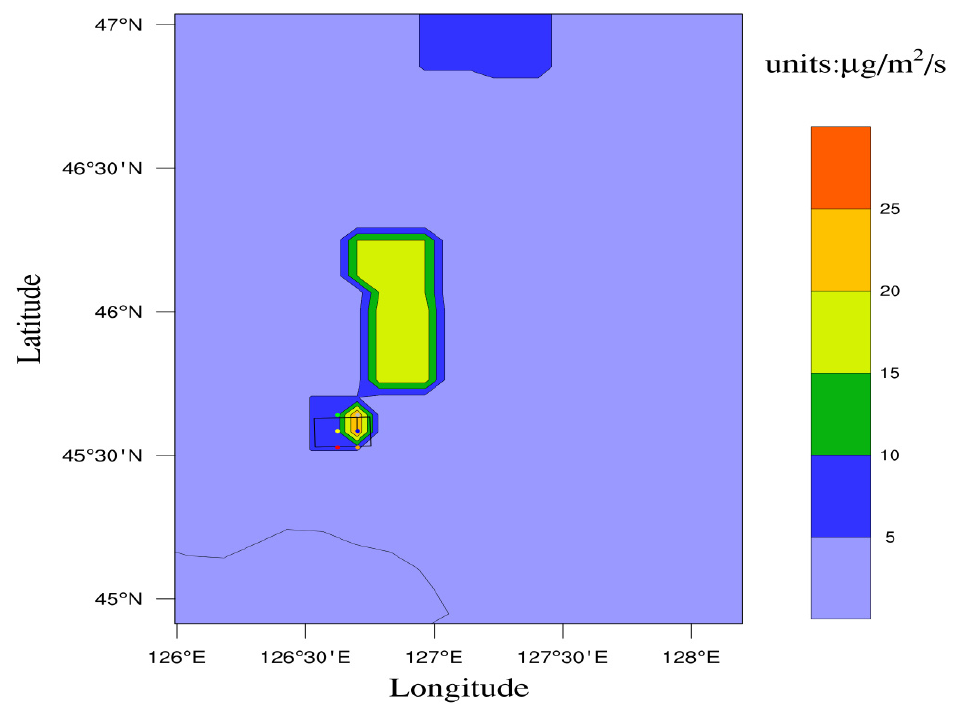
Figure 11. Distribution diagram of the ground emission rate of black carbon aerosol in October 2012 (the rectangle box is the flight area, and the color of the six colored points is consistent with Figure 9).